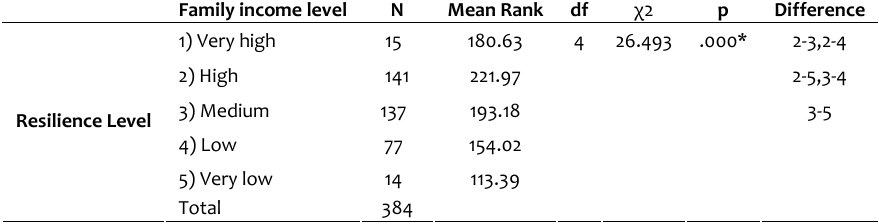
Table 7. Results of Kruskal-Wallis Test on Resilience Levels of the 5-Year-Old Preschoolers According to Family Income